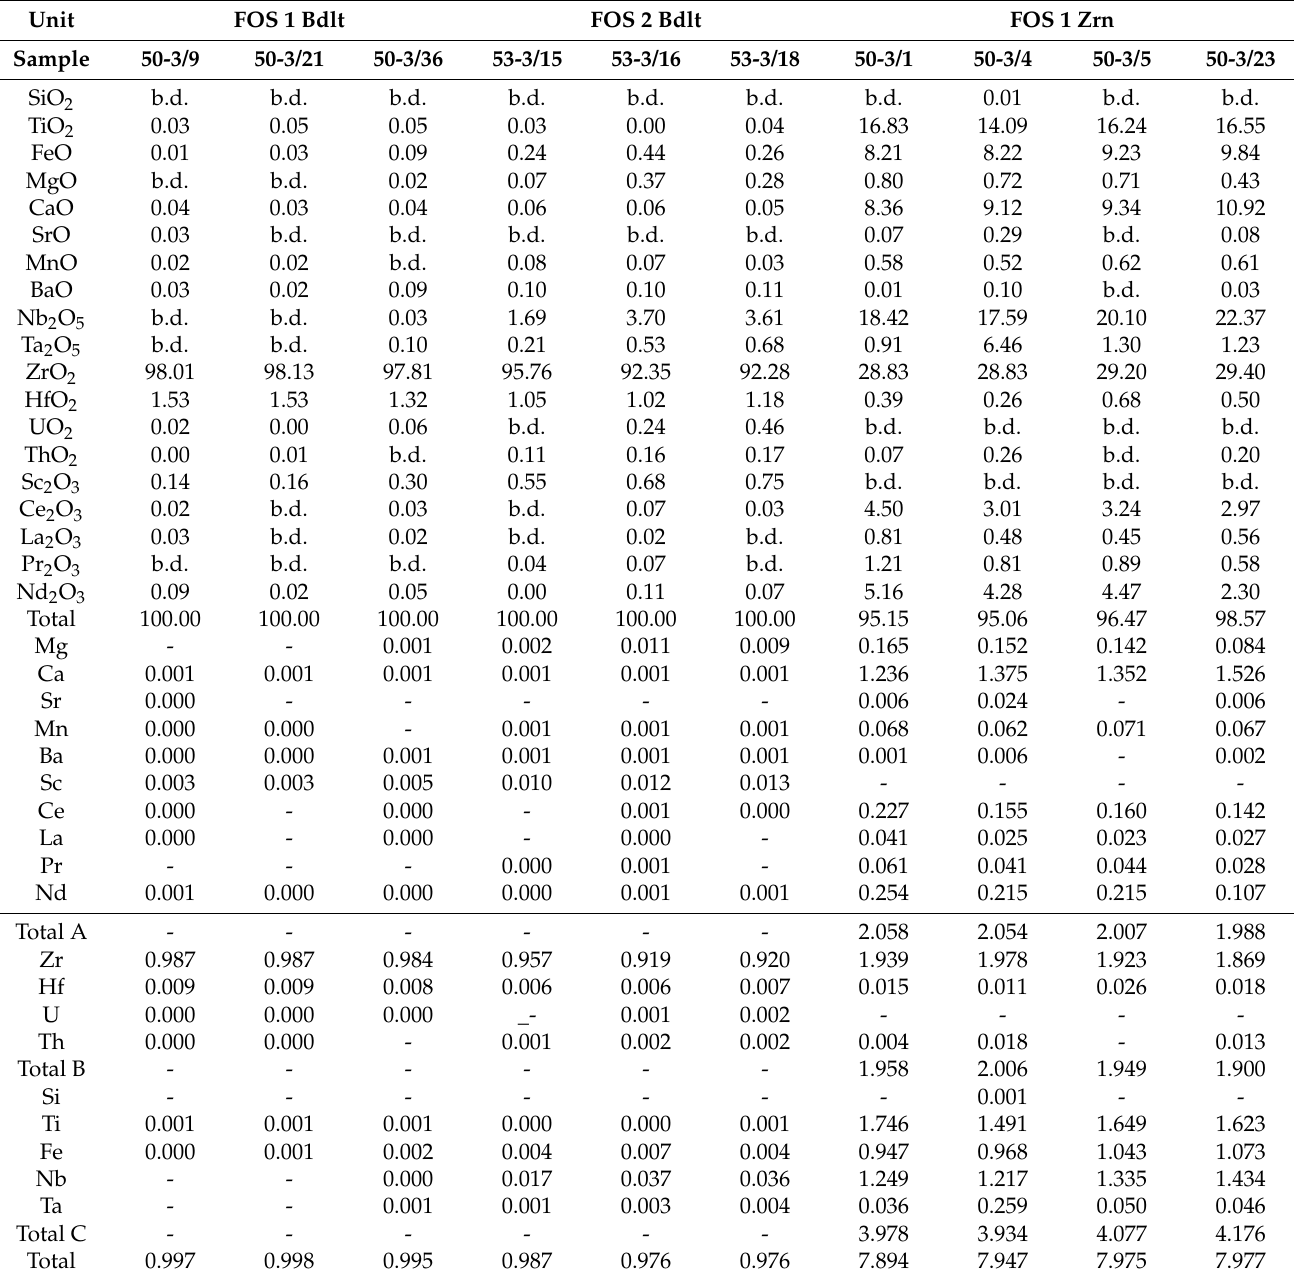
Table 4. Representative compositions of baddeleyite and zirconolite from the phoscorites of the Arbarastakh massif. B.d. = below the detection limit. Baddeleyite analyses were normalized to 100%. The structural formulae of baddeleyite are calculated for two oxygens; the structural formulae of zirconolite are calculated for 28 charges.